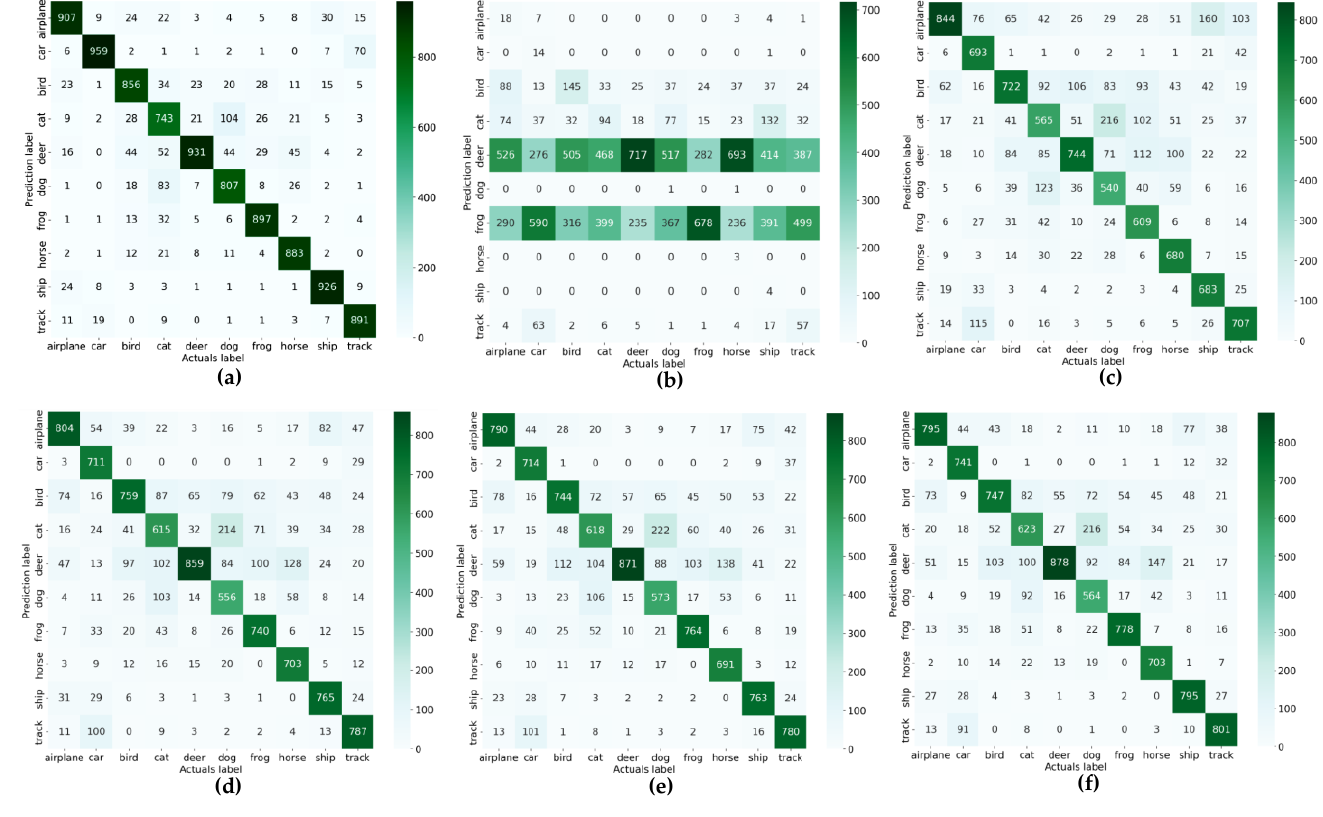
Figure 4. Comparison of recognition results of original and cleaned from 25% random-valued impulse noise images of CIFAR10 test database: ( a ) original database recognition accuracy is 87.99%; ( b ) accuracy of 25% noised database is 17,31%; ( c ) accuracy of denoised base by [28] is 67.87%; ( d ) accuracy of denoised base by [27] is 72.99%; ( e ) accuracy of denoised base by [25] is 73.08%; ( f ) accuracy of denoised base by proposed method is 74.25%. Table 6. Criteria and metrics of recognition accuracy of the CIFAR10 base, previously cleared of 25% random-valued impulse noise.